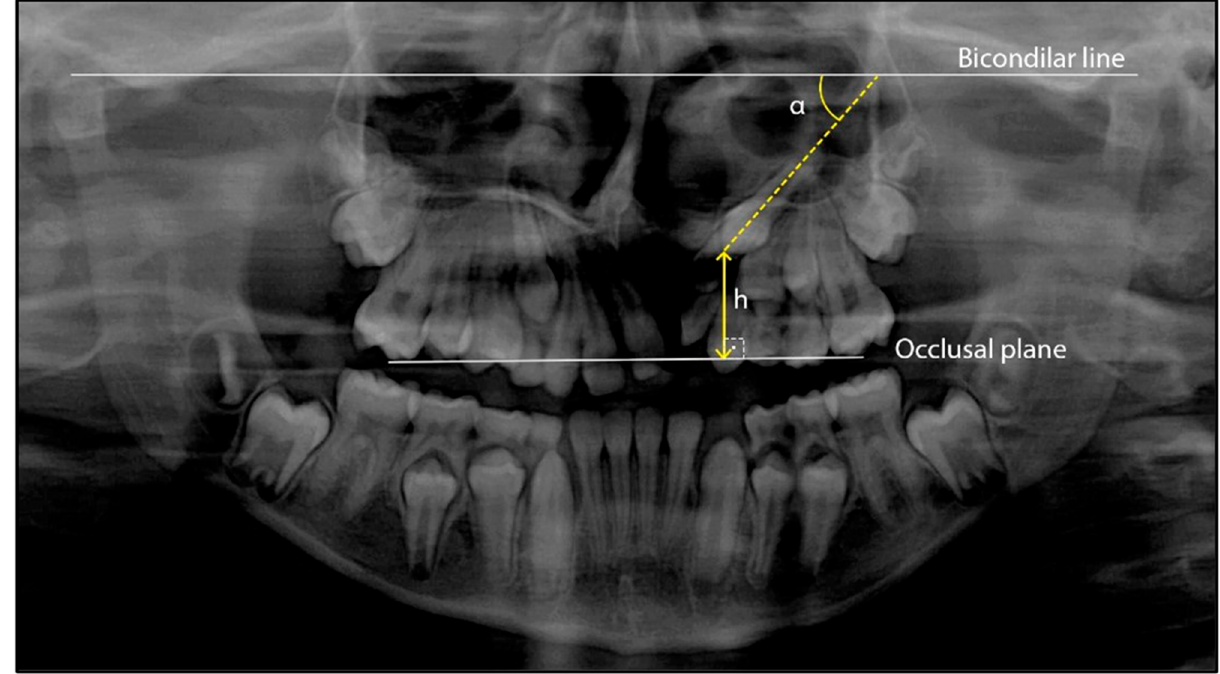
Figure 1- A bicondylar line superior to the condyles was drawn and used as reference to measure the mesiodistal angulation of the permanent canine on the cleft side (α). 21-23 As α decreased, the canine mesiodistal angulation increased. The height of the permanent canines on the cleft side was measured in relation to the occlusal plane by the line drawn from the tip of the mesiobuccal cusp of the maxillary first permanent molars (h).